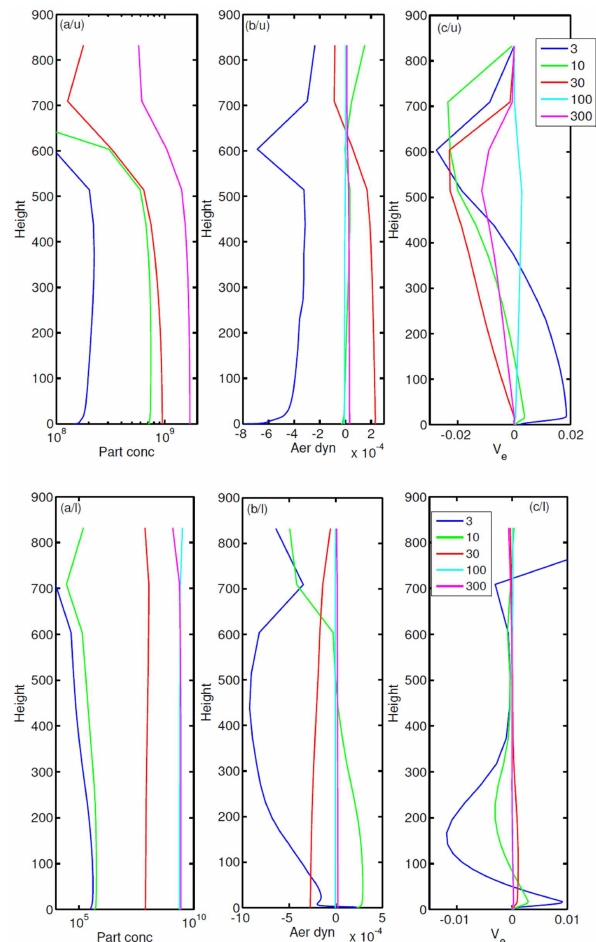
Figure 6. Vertical profiles of the (a) particle concentration (par- ticlesm − 3 ) , (b) change rate due to aerosol dynamics (s − 1 ) , and (c) vertical exchange velocity defined to be positive for downward transport (ms − 1 ) for selected particle sizes on 7 May at 12:00LT (upper panels denoted by “/u”) and 21:00LT (lower panels denoted by “/l”). For panels (b) and (c) normalization with local concentra- tions was